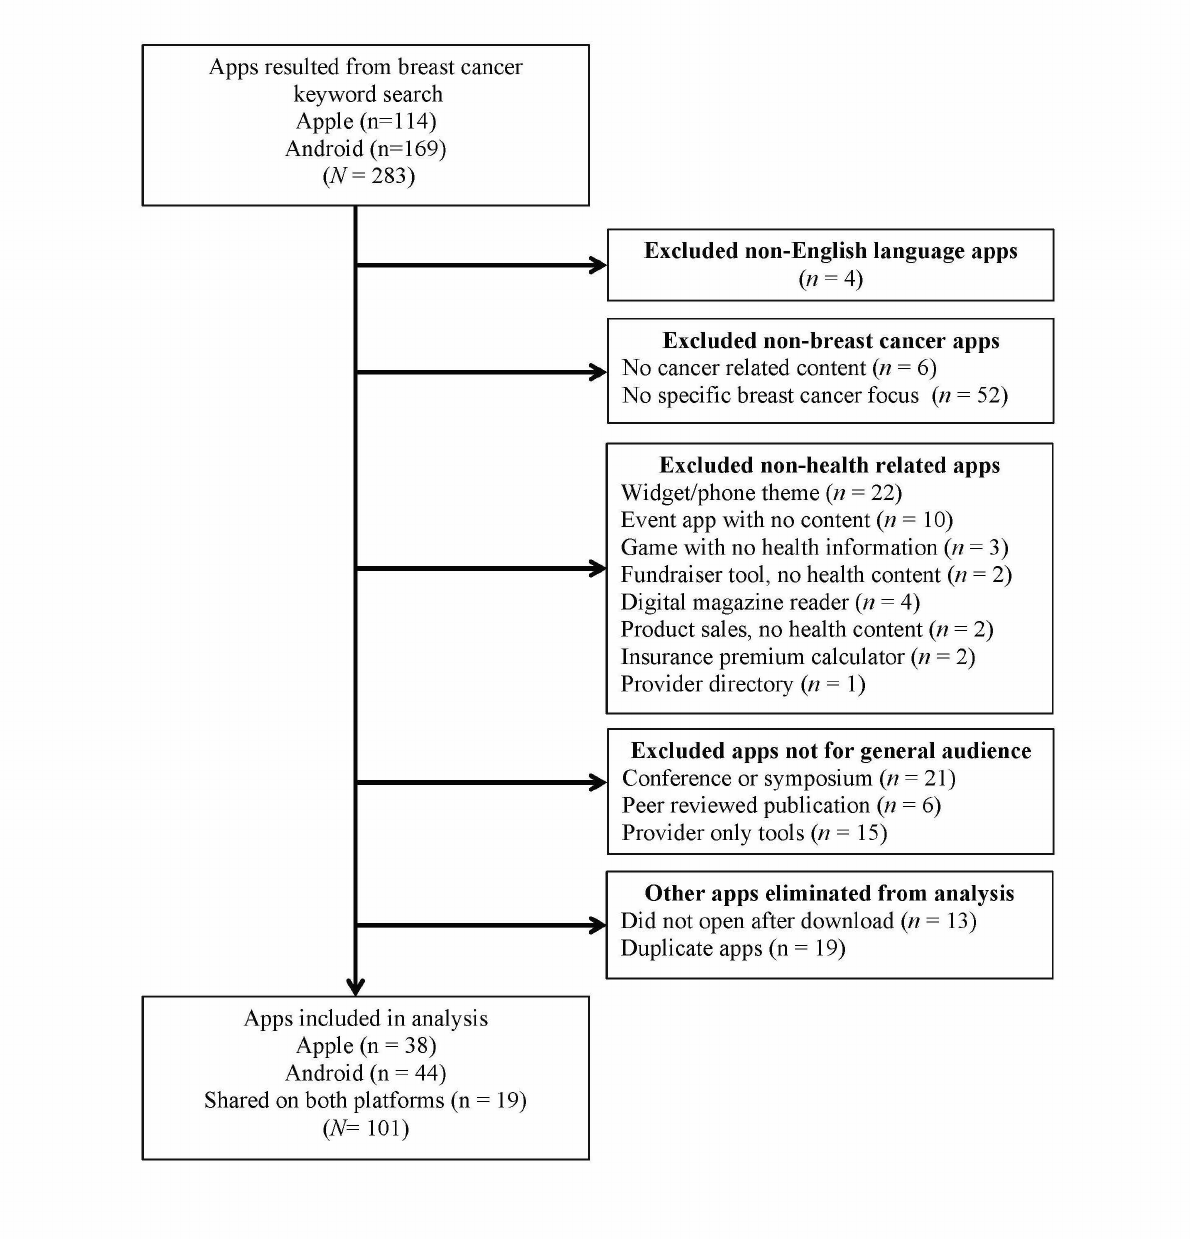
Figure 1. App Exclusion